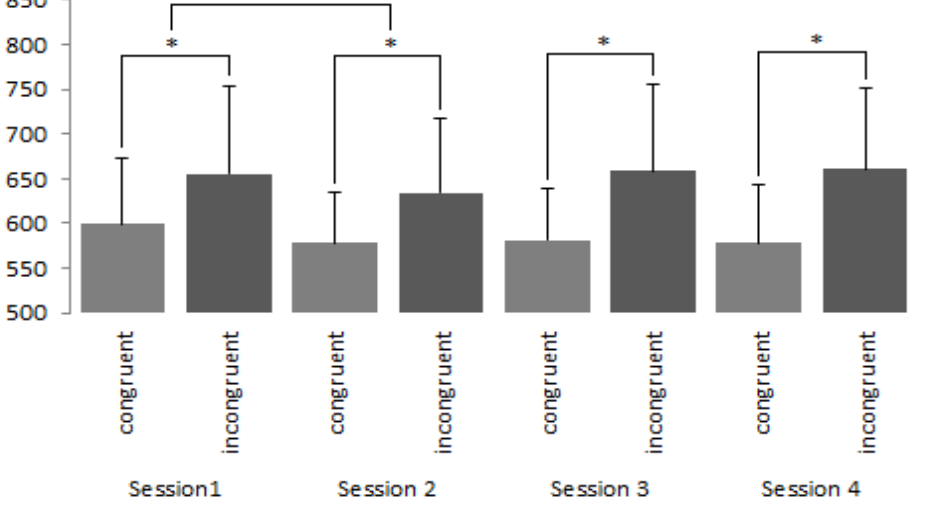
Figure 3. IAT results (in milliseconds) reflecting responses towards liked brands in the congruent and incongruent phases. Whilst significant differences occurred between the congruent and incongruent phases, reaction times were not seen to vary across sessions. * denotes p < 0.001.